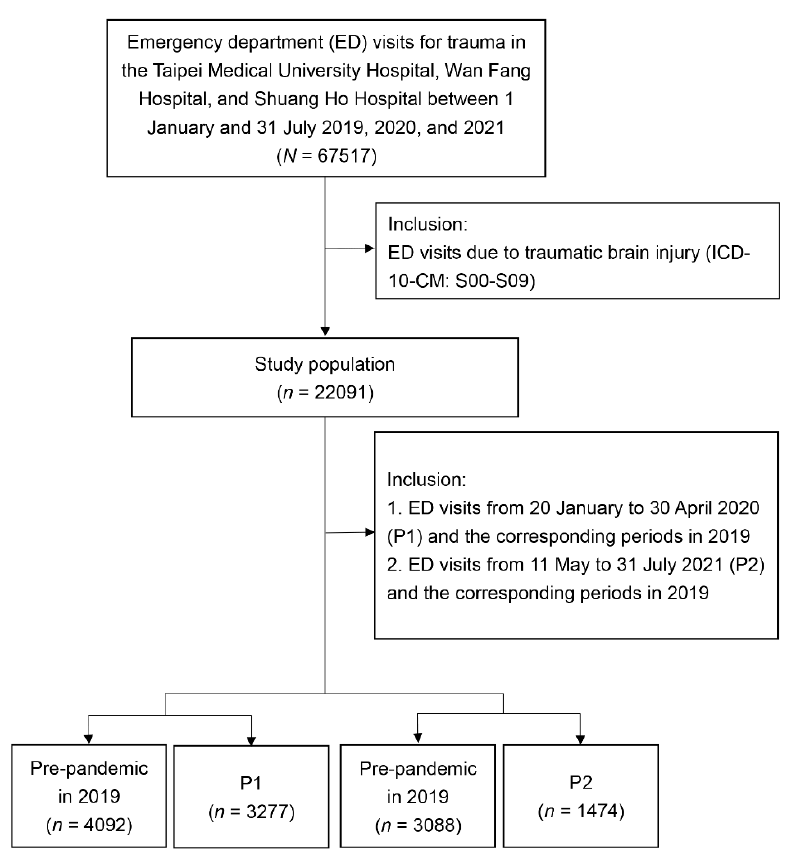
Figure 1. Sample selection procedure from the CRD of Taipei Medical University. CRD, Clinical